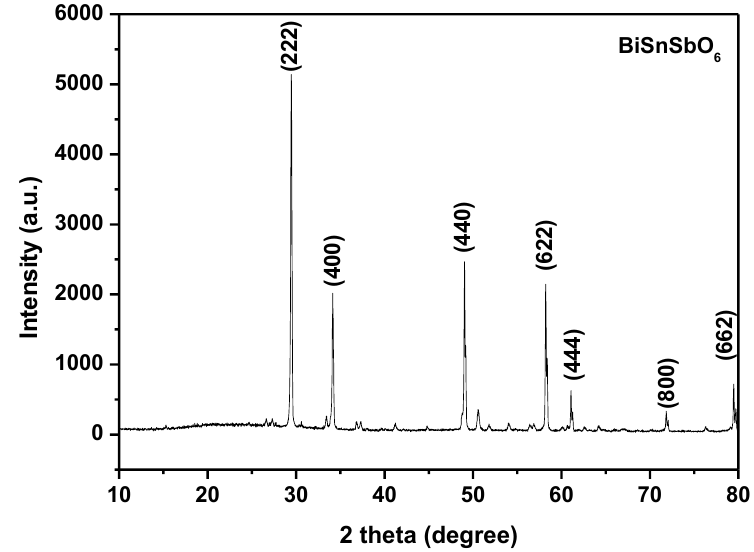
Figure 3. The XRD spectrum of BiSnSbO 6 .